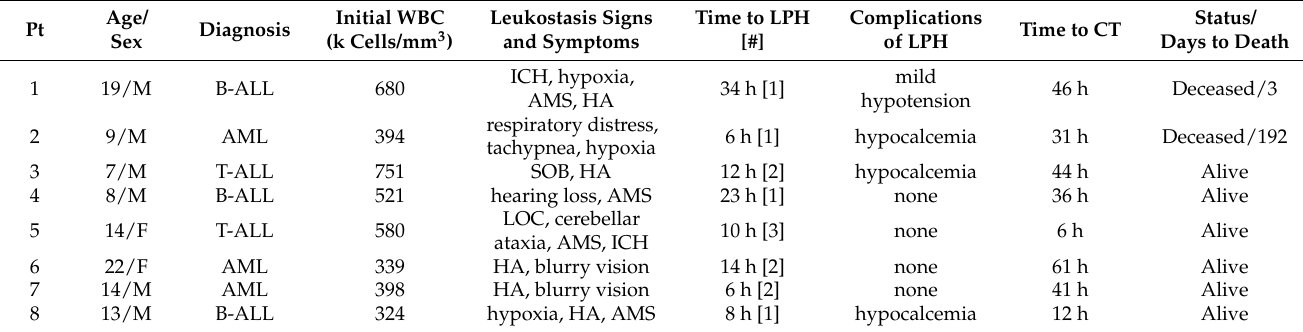
Table 2. The initial presentation and outcomes of patients who had leukapheresis.